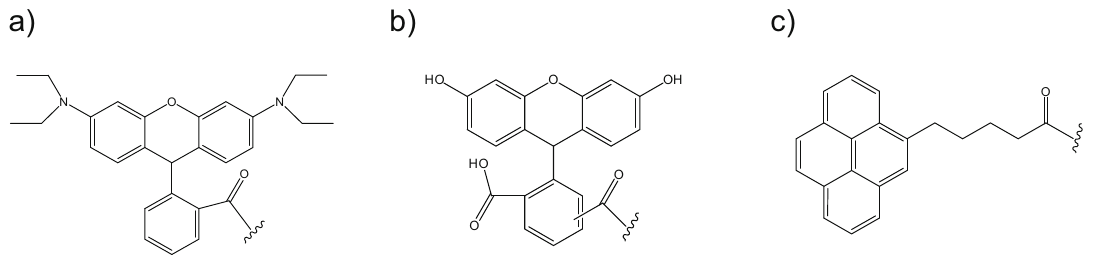
Figure 5: Fluorescent markers: ( a ) rhodamine B, ( b ) 5 ( 6 )- carboxy fl uorescein, ( c ) 4 -( 1 - pyrenyl ) butyric